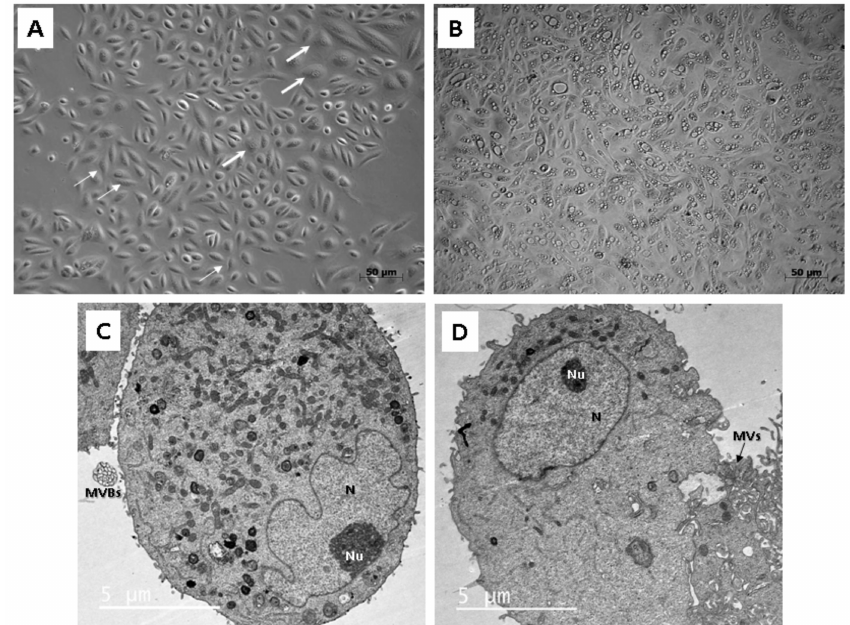
Figure 2. Morphological analysis of the human UDSCs. ( A ) Two different cell morphologies could be microscopically observed within one sample: rice-grain shape (thin arrows) and polyhedral-shape (thick arrows). ( B ) Image of the cell culture depicting dome-like structures, which could be sponta- neously formed in confluent cell populations. These vesicles are filled with liquid and are capable of enlarging their volume, which could lead to the bursting of cells. ( C ) electron micrograph showing proteosynthetically and metabolically active cell with presence of endoplasmic reticulum, mitochon- dria and lysosomes. Multivesicular bodies (MVBs) were clearly visible as well. ( D ) Electronogram of the second type of UDSCs. Cytoplasmic organelles were mostly absent, which might have indicated the inactive form of the cell